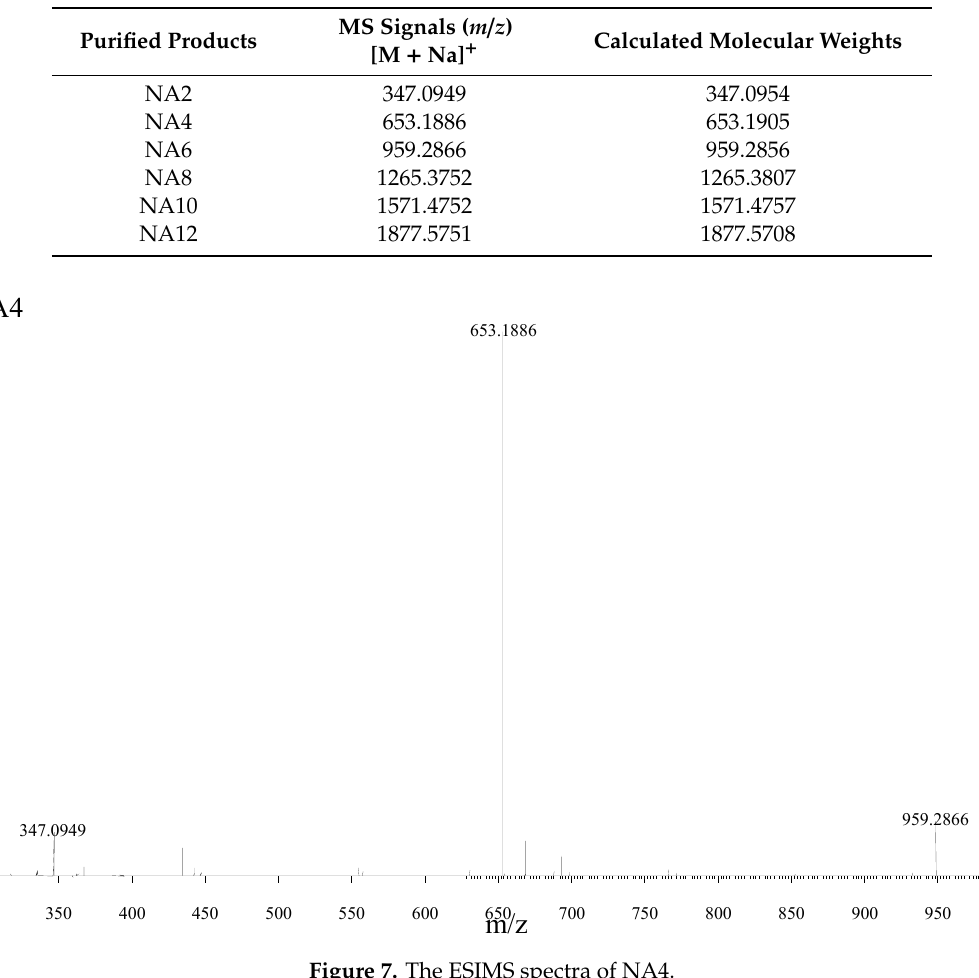
Figure 7. The ESIMS spectra of NA4.